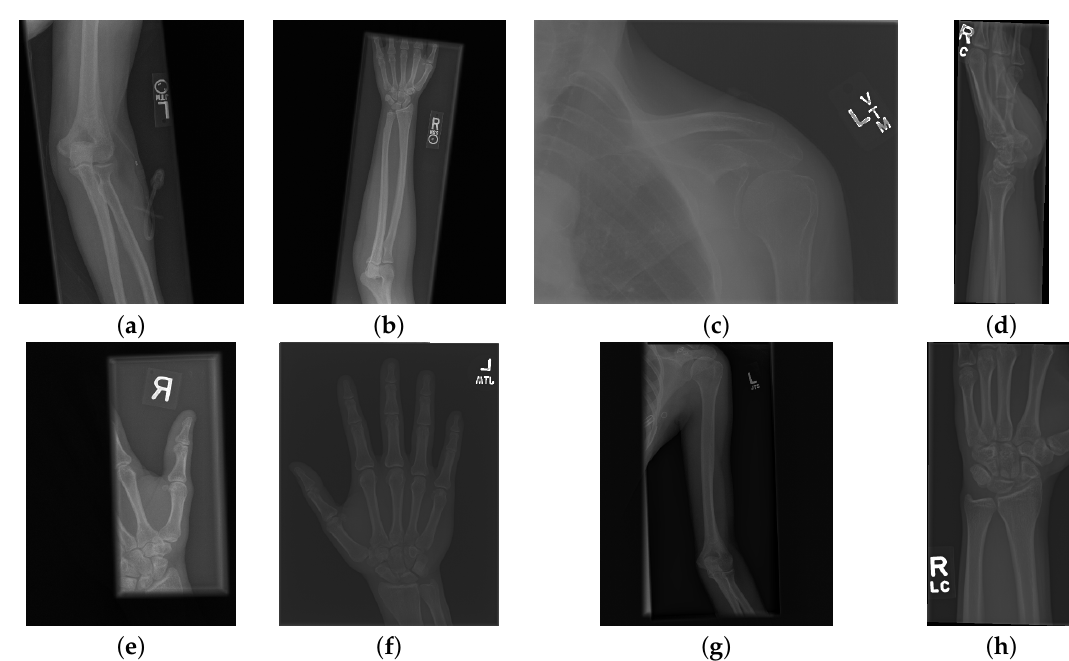
Figure 1. Eight examples of radiographs without abnormalities (considered negative) of the Musculoskeletal Radiographs (MURA) dataset [59]. ( a ) Elbow, ( b ) Forearm, ( c ) Shoulder, ( d ) Wrist (lateral view), ( d ) Lateral view of Wrist, ( e ) Finger, ( f ) Hand, ( g ) Humerus, ( h ) Wrist. It should be noted the variability of the images in terms of dimensions, quality, contrast and the large number of labels (i.e., R for right and L for left), which appear in various locations.